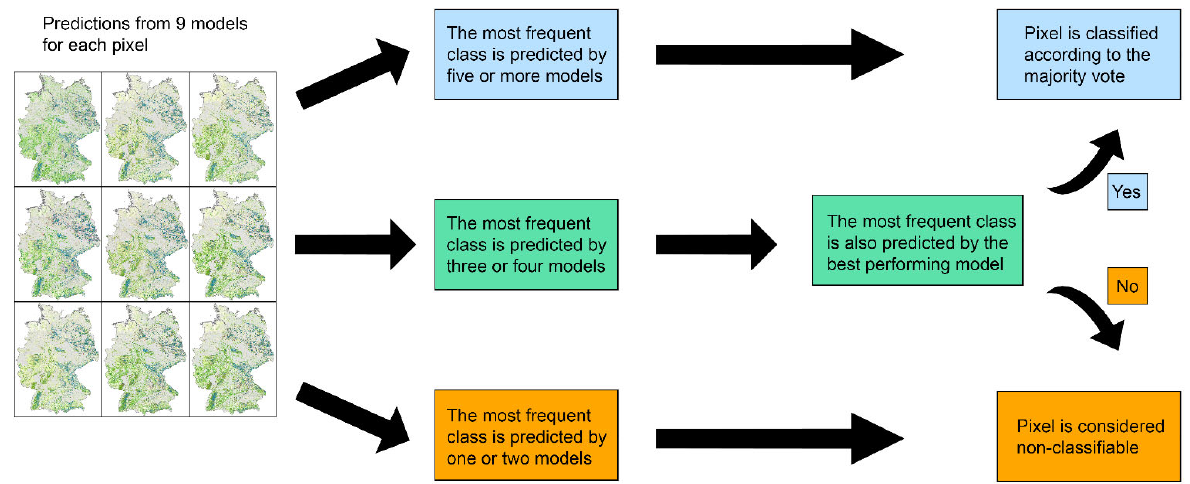
Figure 3. Methodology scheme for the model averaging process. In the ensemble of nine models, each pixel receives a final classification based on the majority vote of all models. Classes are thus assigned by majority vote if at least five of the nine models predict the same habitat type or if at least three models predict the same habitat type including the overall most accurate individual model. If the classification diverges, i.e., less than three models agree on the predicted habitat type, the pixel is also added to the amount of non ‐ classifiable pixels, in addition to those that were previously excluded due to large spectral distances to the average of their class.